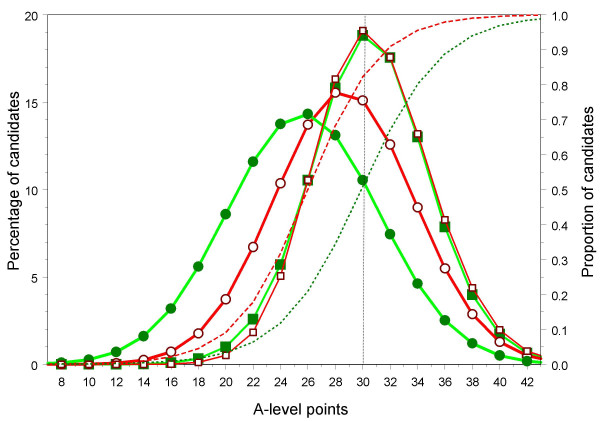
The estimated, underlying, uncensored distributions of A-level ability in medical school applicants and acceptances are shown for W candidates (red lines and open points) and NW candidates (green lines and solid points). The leftmost two lines with circles joined by thick lines show the fitted distribution for the percentages of applicants with particular A-level points, whereas the rightmost two solid lines with square points show the fitted distribution for the percentages of entrants with particular numbers of A-level points; all four lines use the left-hand ordinate. The dashed, ascending lines use the right-hand ordinate and show the fitted proportions of candidates with particular number of A-level points who are accepted, red for W applicants and green for NW applicants.